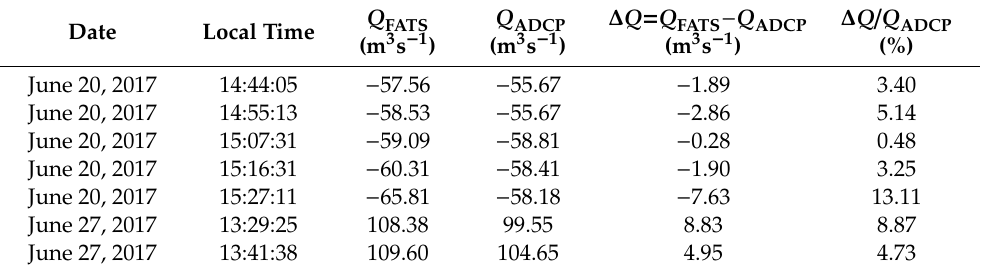
Table 3. Comparison between FATS and acoustic Doppler current profiler (ADCP) measurements at the eastern branch.